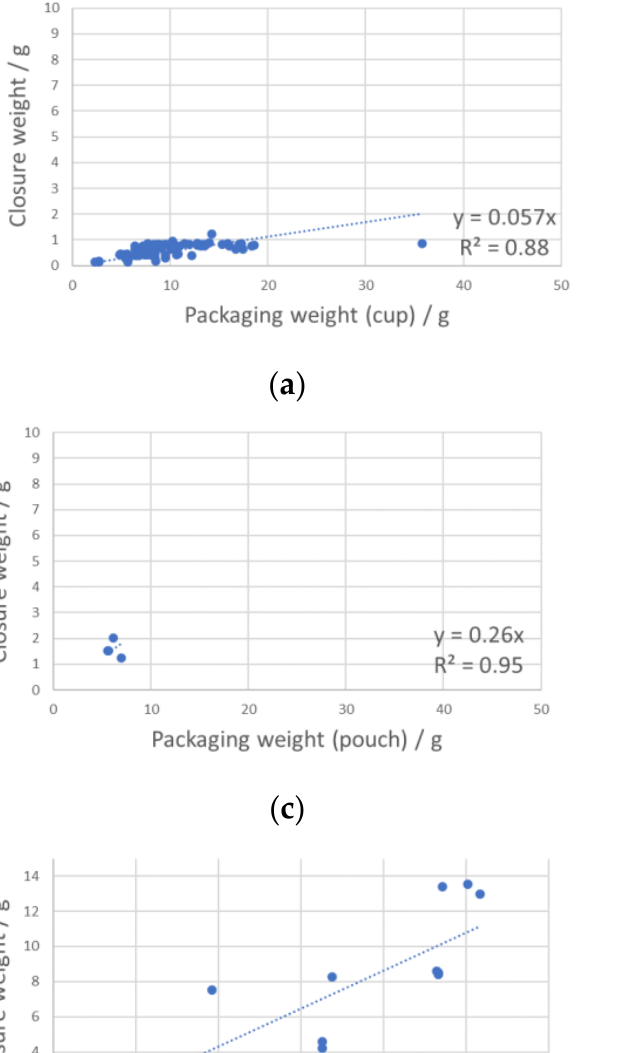
Figure 11. Ratio of closure weight to packaging weight (all parts including wrapper and shrink label if applicable) . 3.3. Packaging Efficiencies at All Different Types of Packaging Packaging Efficiencies Related to Food Product Weight In Figure 12 the food product weights (packaged food) versus the packaging weights are shown. The food product weight was taken from the packaging declaration, e.g., labels or prints (the results for the body without closure, but with in-mould label, because it could not be removed and with all packaging parts used for a single packaging, are de- picted in Supplementary Materials, Figure S2). In case of bundles wrappings are distrib- uted evenly to each packaging. For representation, a linear correlation is included. By the results is shown that the packaging weight and the product weight have no strong correlation. Because of the different packaging means used, different packaging weights can be found in one packaging category. (Also, the density of product can cause different results even for the same filling volume. This was not further examined). This data was used for the calculation of the packaging efficiencies (see next paragraph).